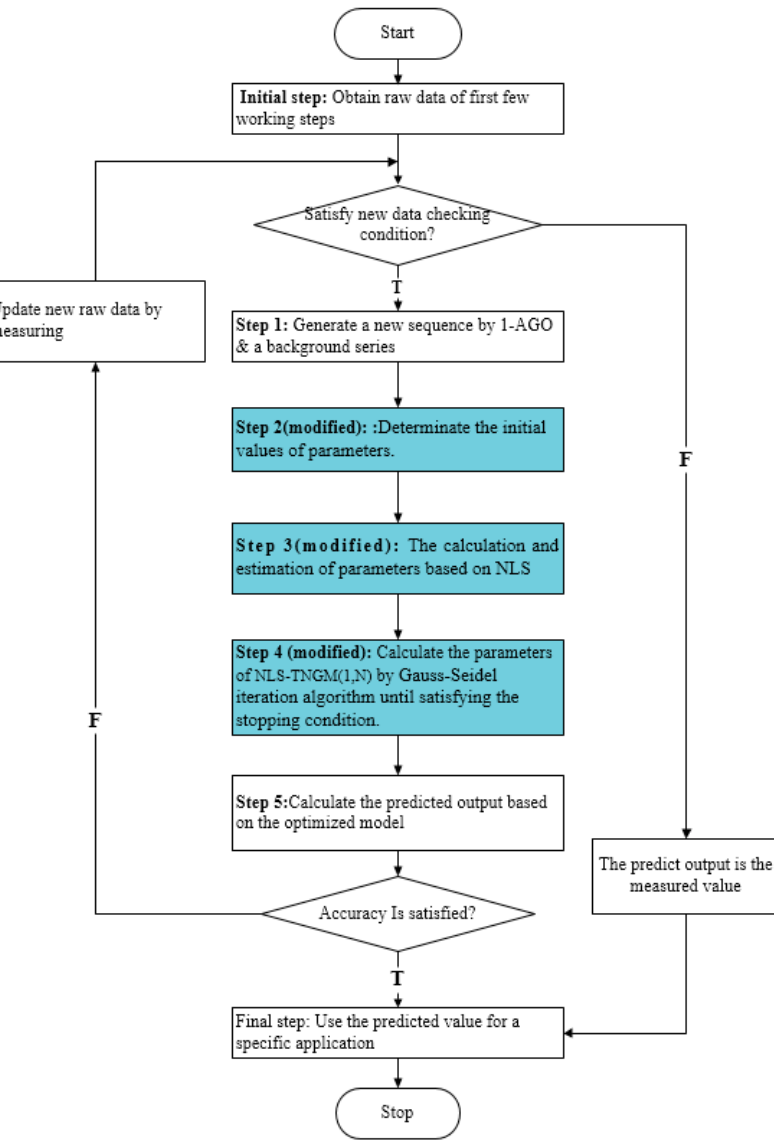
Figure 1. The calculation steps using the transformed nonlinear grey multivariable TNGM (1, N ) based on Nonlinear least squares method.